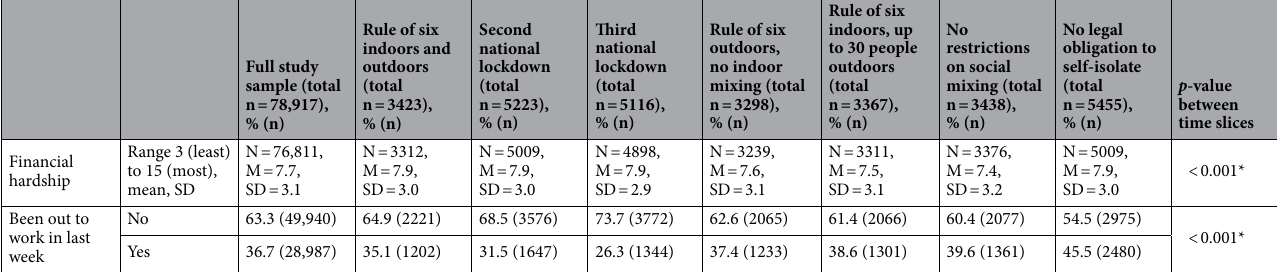
Table 3. Respondent socio-demographic characteristics and workplace attendance for the full study sample, and within each time slice. * p ≤ 0.004.